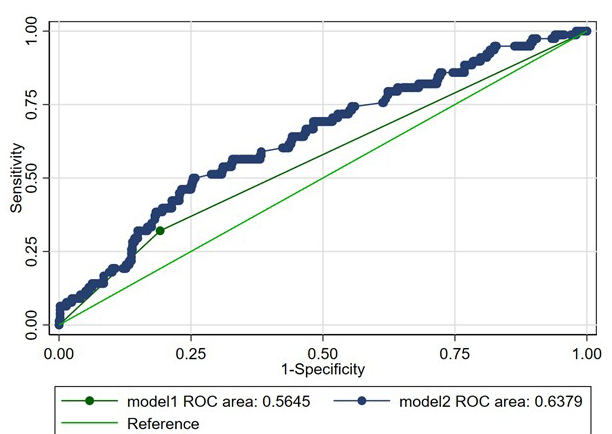
Fig. 1 - Receiver operating characteristic curve for bleeding and HAS-BLED score (model 1) and HAS-BLED score, body surface area, and extracardiac arteriopathy (model 2).